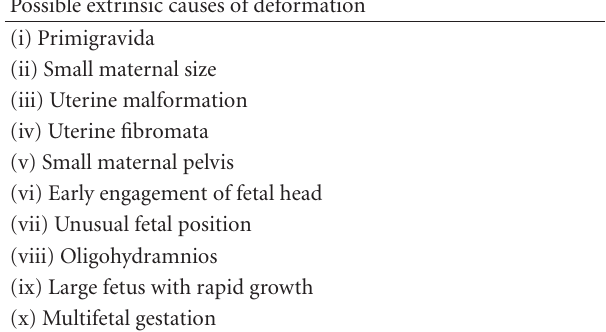
Possible extrinsic causes of